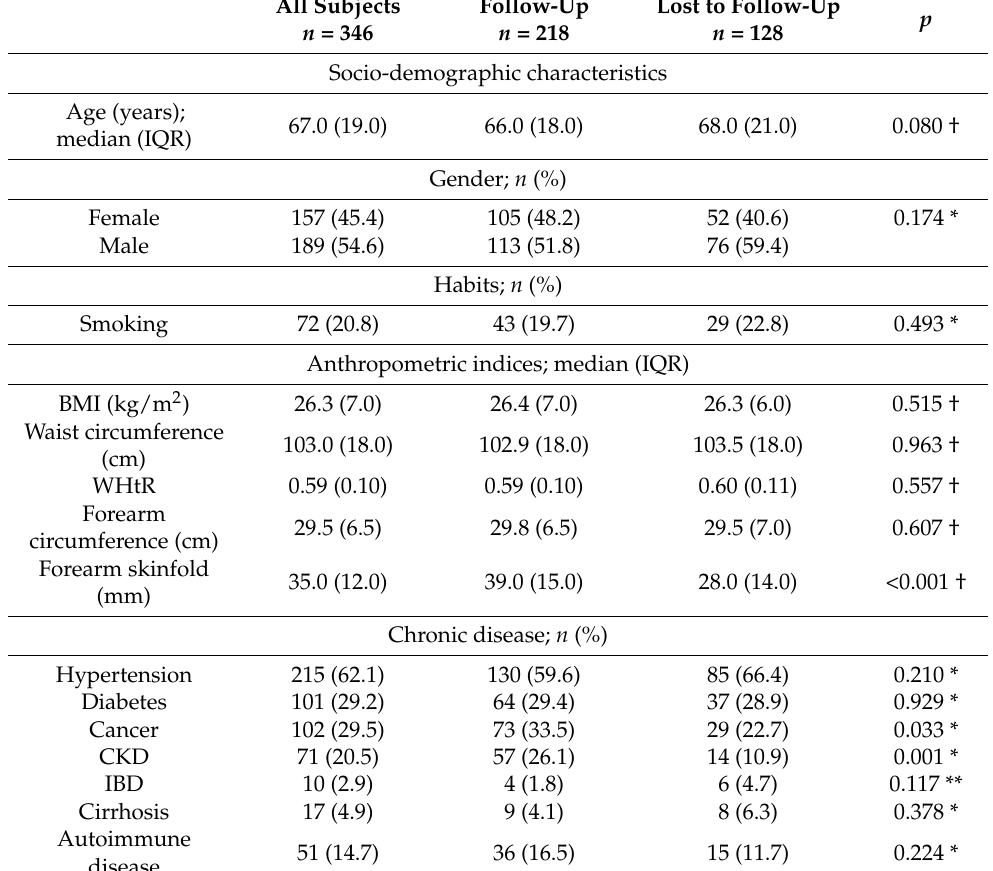
Table 1. Baseline characteristics of